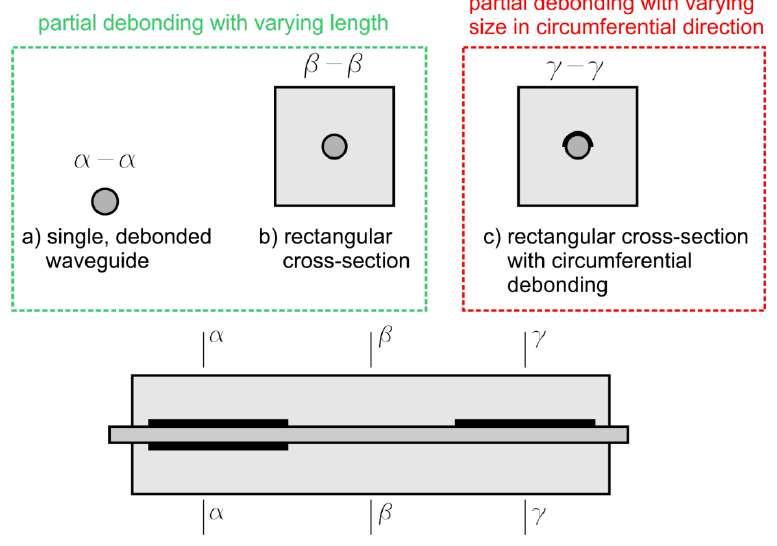
Figure 2. Types of cross-sections distinguished in partially debonded reinforced concrete beam: ( a ) single, debonded waveguide, ( b ) rectangular reinforced concrete cross-section, and ( c ) rectangular cross-section with circumferential debonding between concrete cast and steel rod.